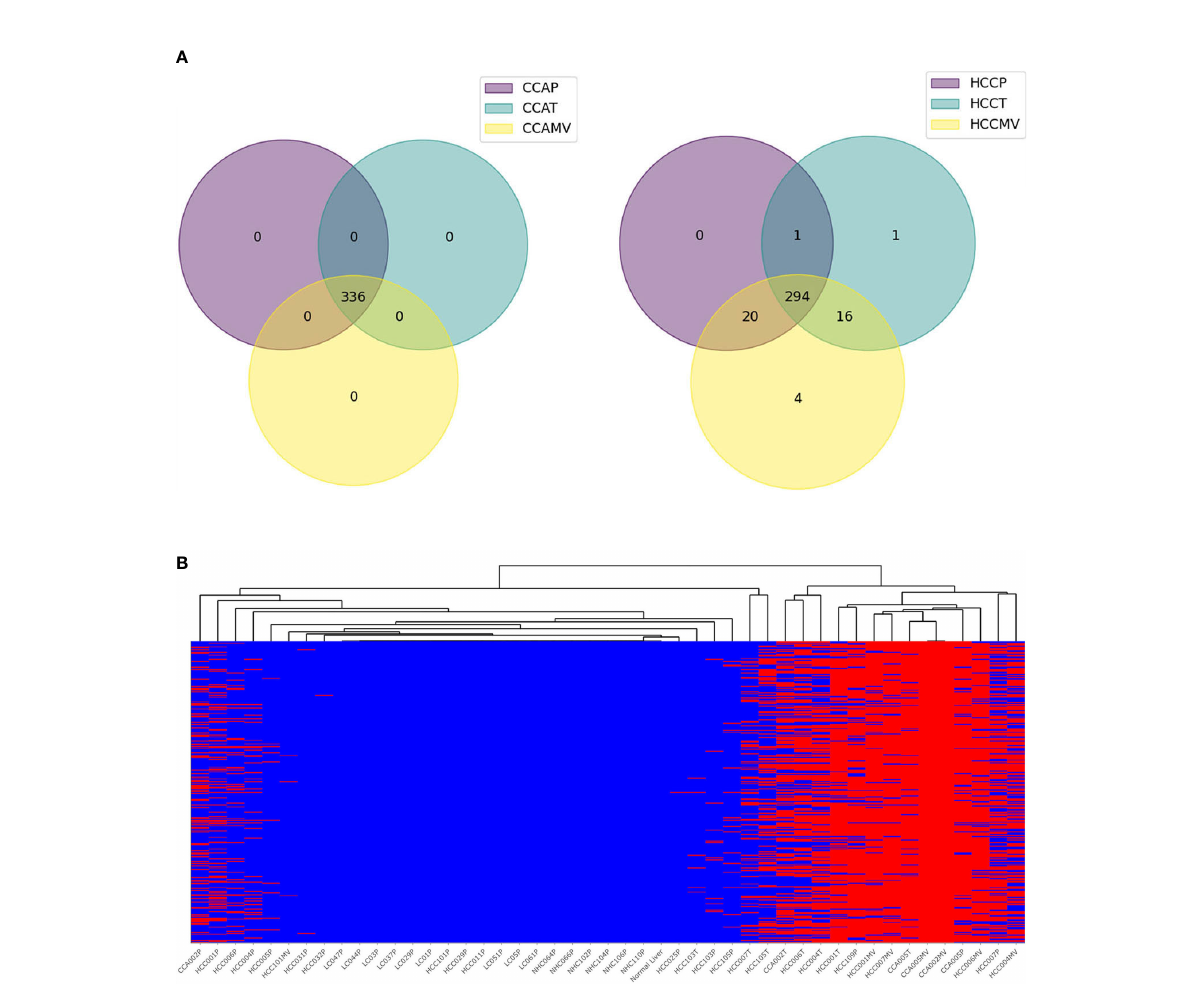
FIGURE 7 High-risk concordant variants associated with cholangiocarcinoma. (A) . Pie charts representing profound synergy in high-risk variants between HCC and CCA patients. All 336 high-risk variants concordant in CCA samples (n=6) are also detected in HCC samples but none in LC and NHC controls. (B) . Heat map representing the pro fi les of concordant CCA variants in various samples. The annotation of variants is shown in Supplementary Table